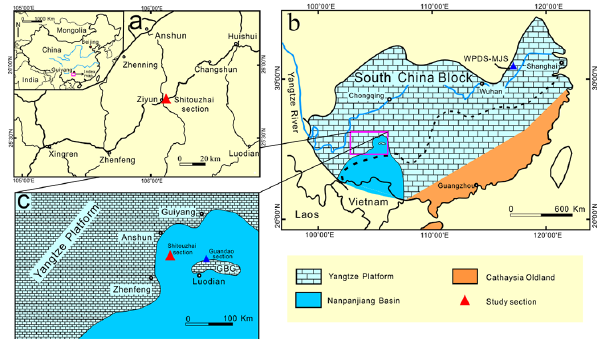
Figure A1. (a) Geographic map of southern Guizhou Province, South China, showing location of the Shitouzhai section in Ziyun County (modified from the Geographic Map of China, http://map. baidu.com). The red rectangle in the inset map of China shows the location of the study area. Early Triassic paleogeography of (b) the South China block and (c) the study area (modified from Feng et al., 1997). Note that the locations of the West Pingdingshan (WPDS) and Majiashan (MJS) sections are shown in (b) and that of the Guandao section in (c) . GBG stands for Great Bank of